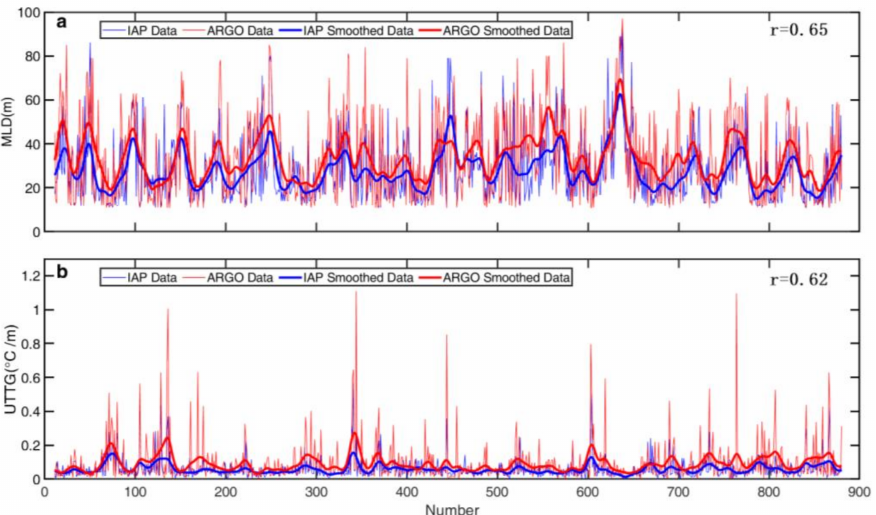
Figure 1. Comparison between ( a ) the MLD (m) and ( b ) UTTG ( ◦ C/m) calculated from the IAP dataset (blue lines) and the Argo dataset (red lines). The thin and weighted lines represent the original and 21-point smoothed data, respectively.